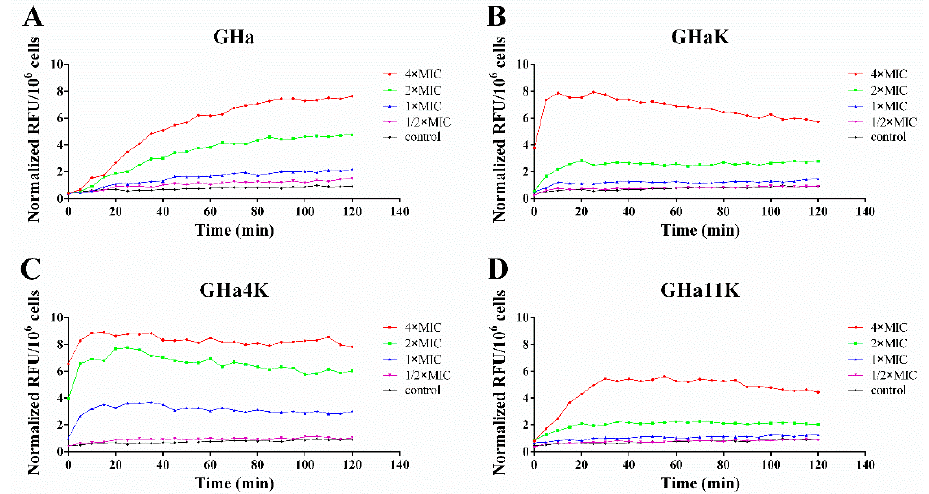
Figure 4. The membrane permeability assay on S. aureus by fluorescence spectroscopy. Bacteria were treated by ( A ) GHa, ( B ) GHaK, ( C ) GHa4K, and ( D ) GHa11K at various concentrations. Normalized RFU: normalized relative fluorescence units.